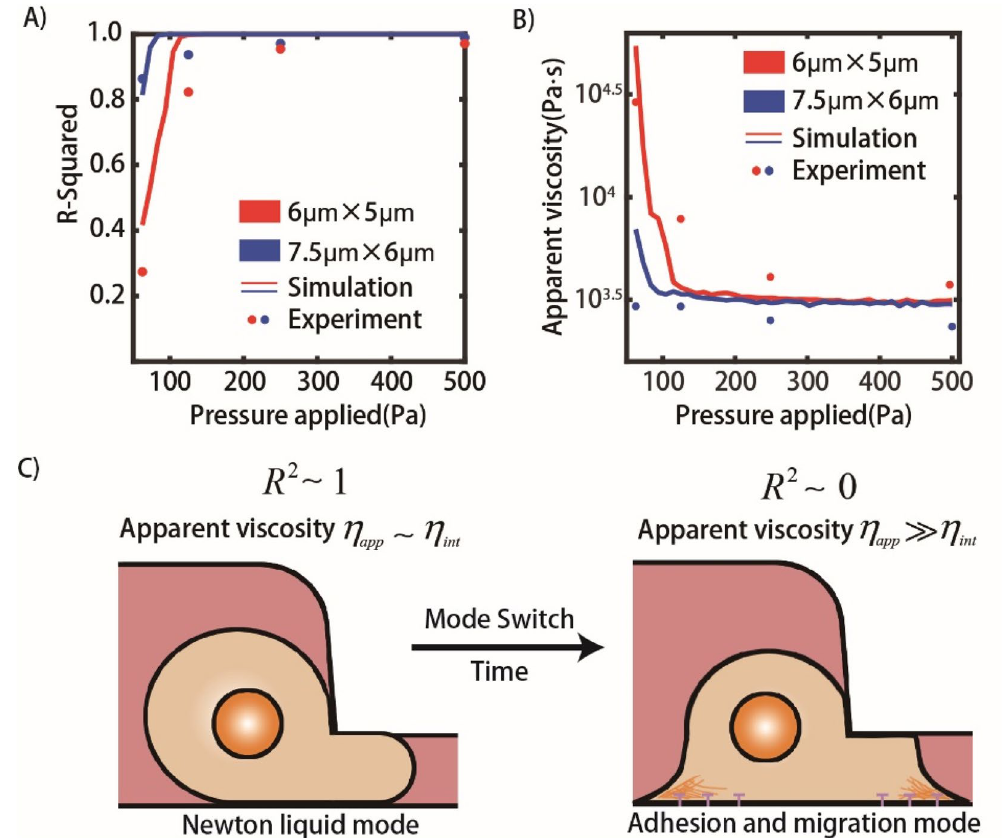
Figure 6. The summarization of the R-squared and the apparent cell viscosity of the cell traverse-vessel behaviors at different conditions. ( A , B ) The comparison of plots of R-squared and cell apparent viscosity as functions of pressure applied for experiments and simulations under different pressure differences (median of all available cells in one condition, and no less than 80 cells in any condition at any time). ( C ) Illustration of cell transition from Newtonian liquid mode to adhesion and migration